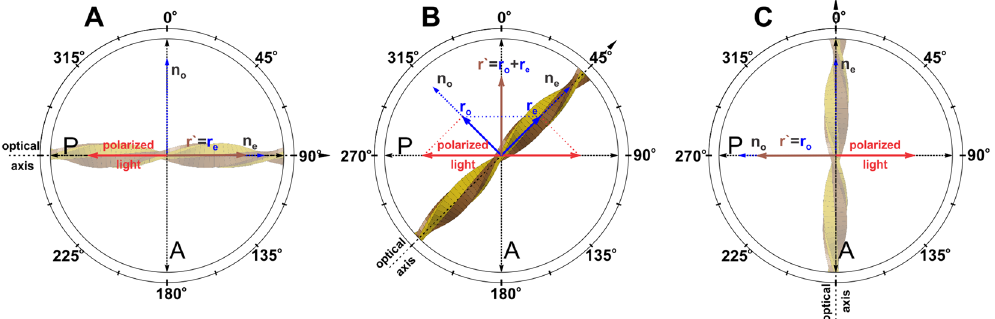
Figure 1. Optical properties of α S fibrils. The blue dotted line vectors represent the ordinary n o (fast) and extra ordinary n e (slow) optical axes of the fibril (yellow). P and A designate the polarizer and analyzer respectively. The blue continuous line vectors and r e show the polarization of the ordinary and extra ordinary rays. r ′ is the resultant; the orientation of this vector shows the polarization at which maximum amount of light is transmitted by the fibril, and the length is proportional to the intensity. The red arrows show the polarization of the illumination light. ( A and C ) If the optical axis of the fibril stays at an angle that is a multiple of 90° with respect to the polarization axis of A (or of P), the light is completely extinguished r ′⊥ A → no transmitted light. ( B ) In contrast, if the angle is a multiple of 45°, maximal amount of light is transmitted r ′ = r ′ o + r e